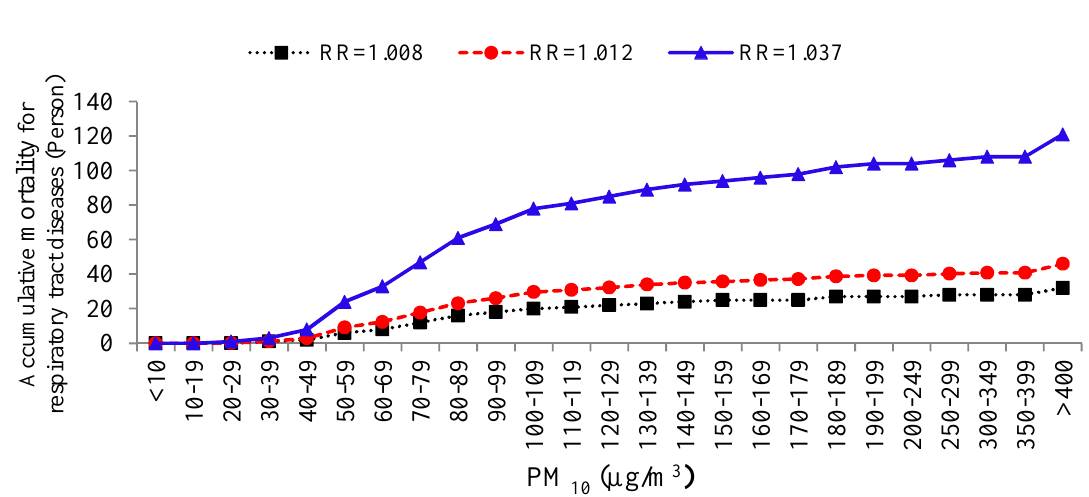
Figure 2. Accumulative mortality due to cardiovascular diseases attributed to PM based on PM concentration in Kermanshah in 2011 10